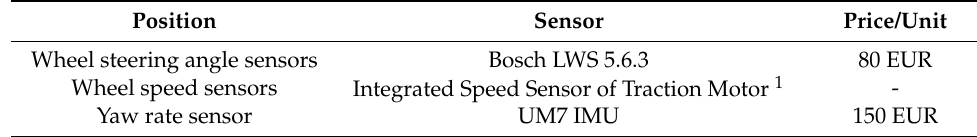
Table 1. List of the sensors on the demonstration vehicle.